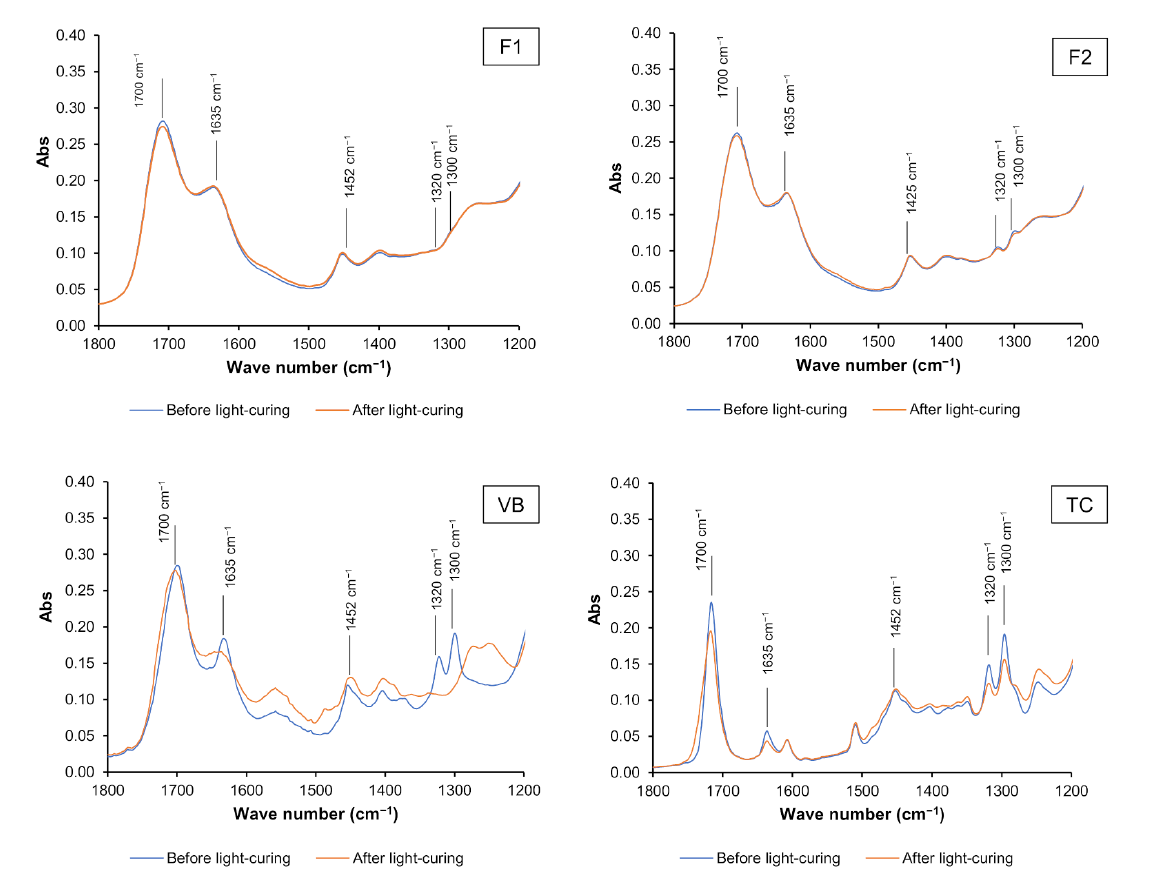
Figure 4. The FTIR spectra before and after the light-curing of the representative specimens in each group.